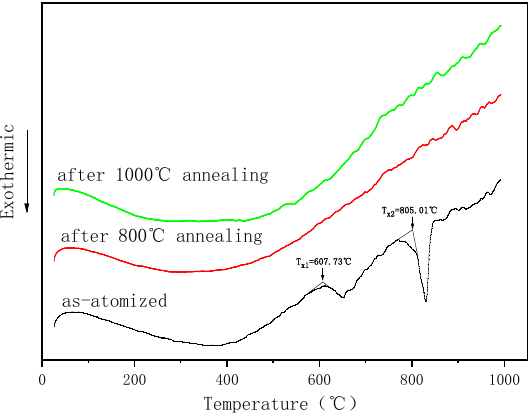
Figure 5. DSC curves of Fe-W-B amorphous powder as atomized and annealed. Focused ion beam (FIB) sample image and EDS area microanalyses of as-atomized Fe-W-B amorphous powder are shown in Figure 6. EDS microanalyses show that the distribution of W and B elements are uniform within the Fe matrix, which conforms to the amorphous characteristic.